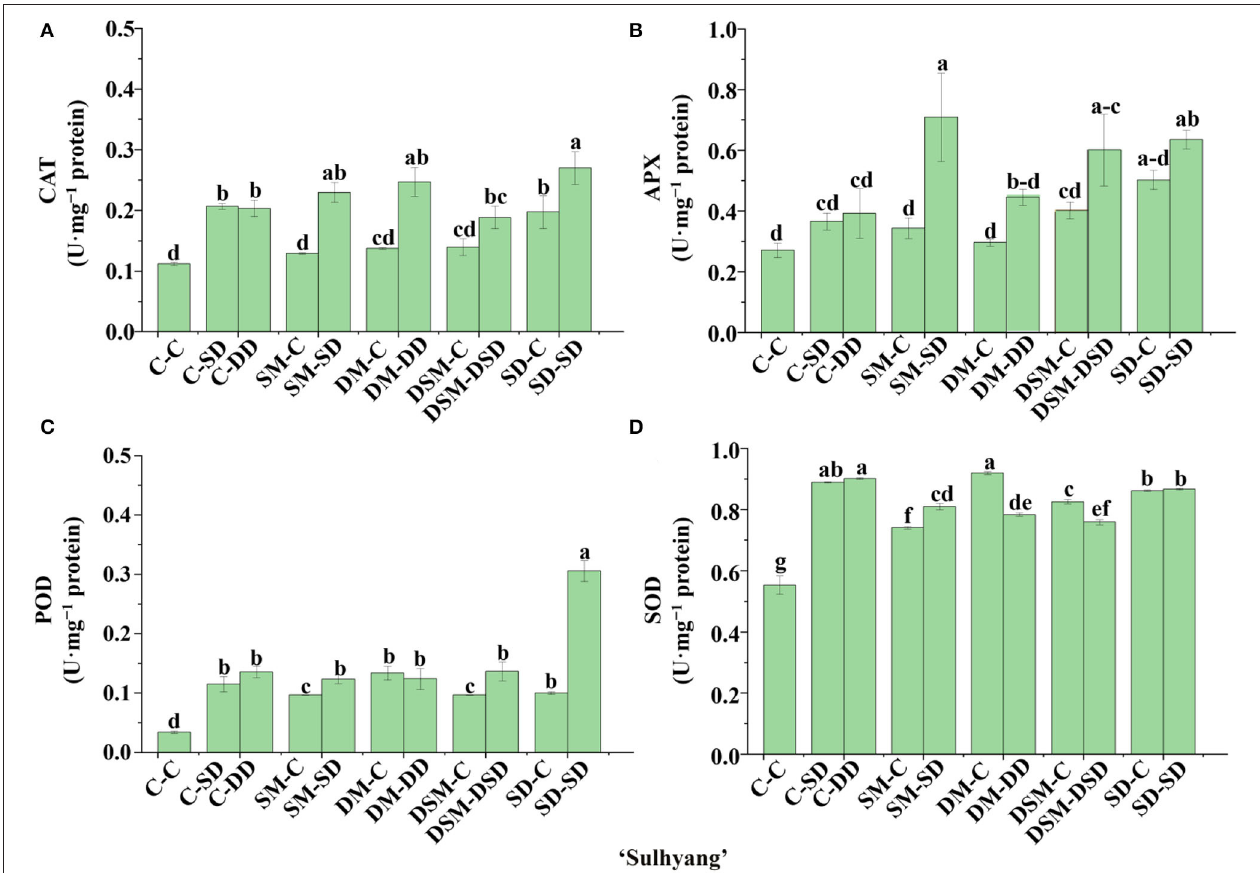
FIGURE 11 | Activities of CAT (A) , APX (B) , POD (C) , and SOD (D) in leaves of “Sulhyang” as affected by the Si treatment after subjection to 43 ◦ C for 7 days. Lowercase letters indicate significant differences calculated by the Duncan’s multiple range test at p ≤ 0.05. See Figure 1 for descriptions of treatment